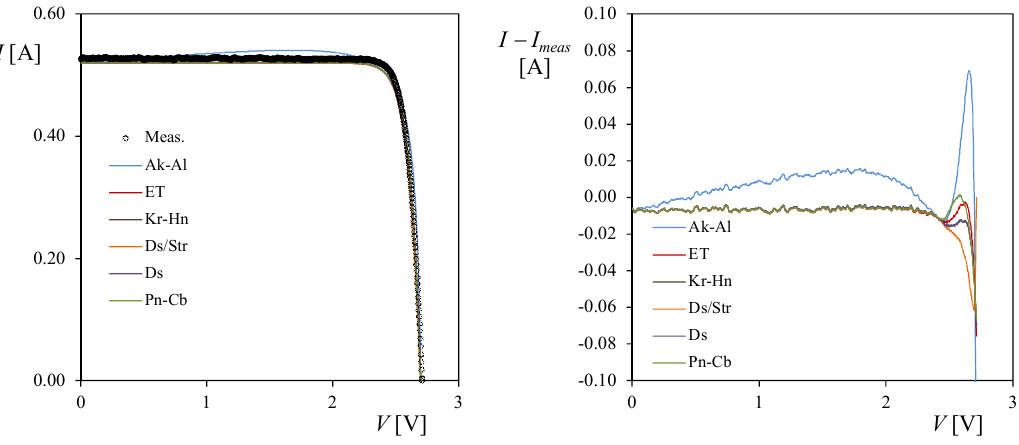
Figure 7. Curves for the explicit models analyzed, fitted to the Azur Space 3G30C solar cell data using the analytical methods proposed; see Section 2 ( left ). The error in relation to the data is also included in the figure ( right ).